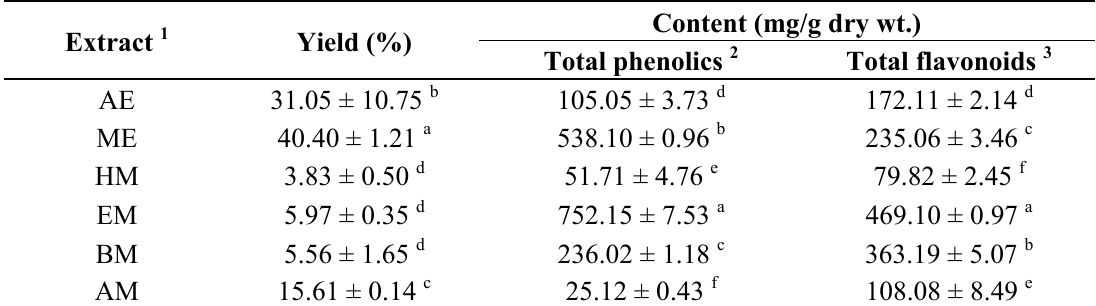
Table 1. Yield, total phenolic contents and total flavonoids in different solvent extracts of Bidens pilosa L. var. radiata